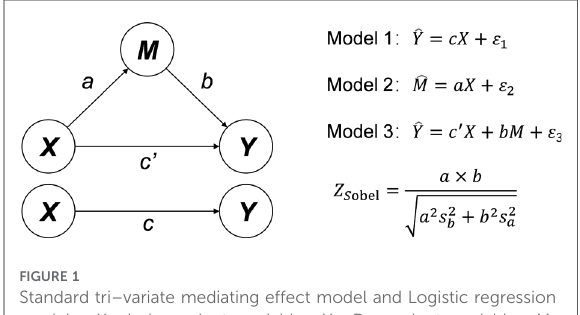
FIGURE 1 Standard tri – variate mediating effect model and Logistic regression models. X: Independent variable. Y: Dependent variable. M: Mediator.